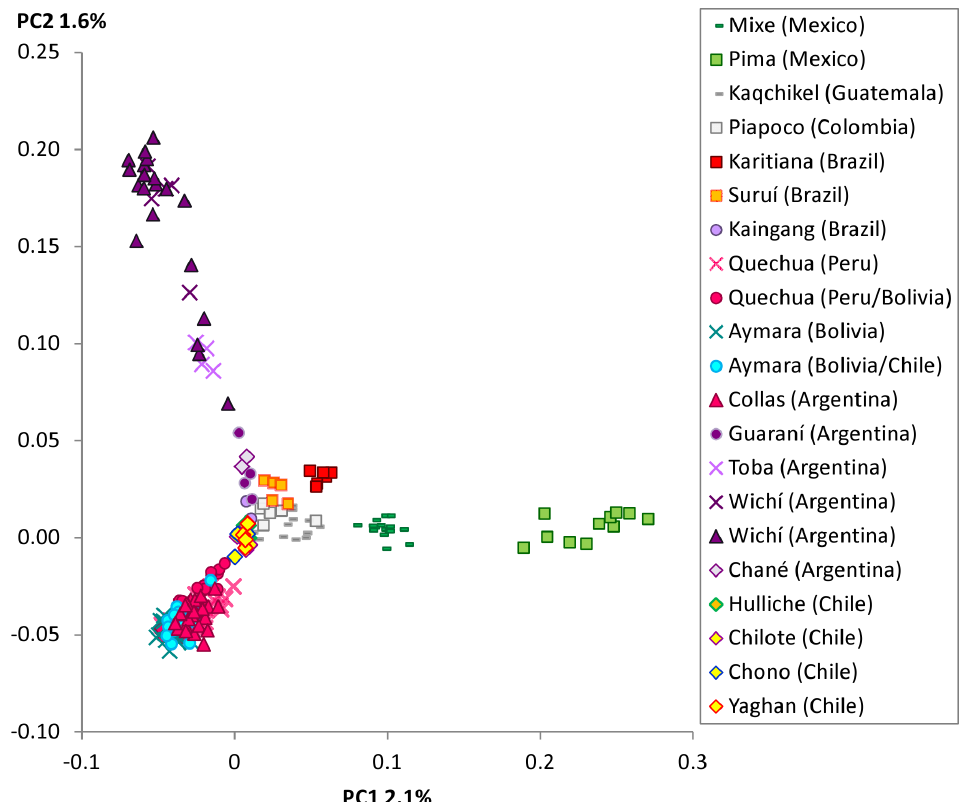
Figure 2. PCA of Native Americans from Mexico to Chile. Triangles: populations of this study; squares: HGDP, Quechua (Peru) and Aymara (Bolivia) were first published by Mao et al [63], remaining populations by Reich et al [64]. Wichı´ were included from this study and Reich et al [64] and Quechua and Aymara were both published by Mao et al [63] and Reich et al [64]. PC2 separates Wichı´ from Andean highland populations (Collas, Quechua and Aymara). PC1 distinguishes Mexican Pima and Mixe from the remaining populations. Collas cluster among Aymara and Quechua. The next closest populations are Chileans also from the Andean language family (Hulliche, Chilote, Chono and Yaghan). Gran Chaco populations (Wichı´, Chane´, Guaranı´, Toba and Kaingang) show the widest spread while Wichı´ are as distinct to the Andean populations as Pima from Mexico.